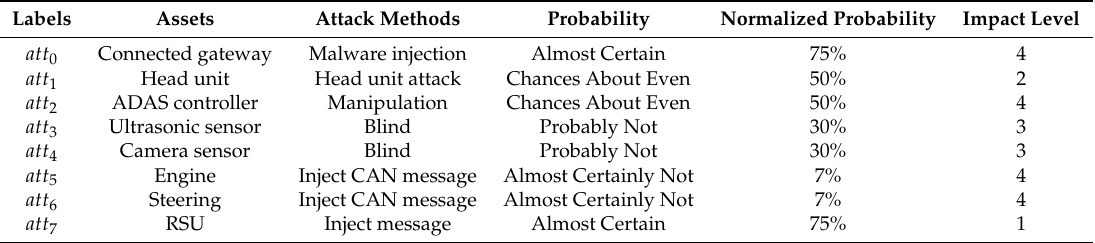
Table 3. Identified assets and